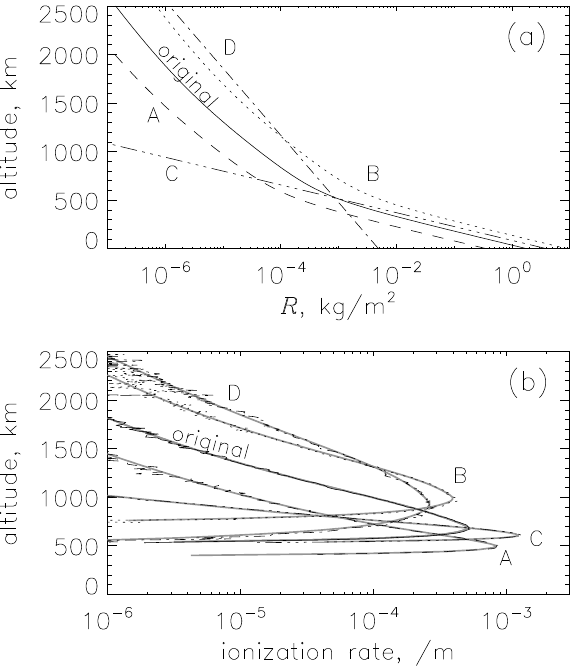
Figure 5: 2007.12.18: Y. Hiraki and C. Tao